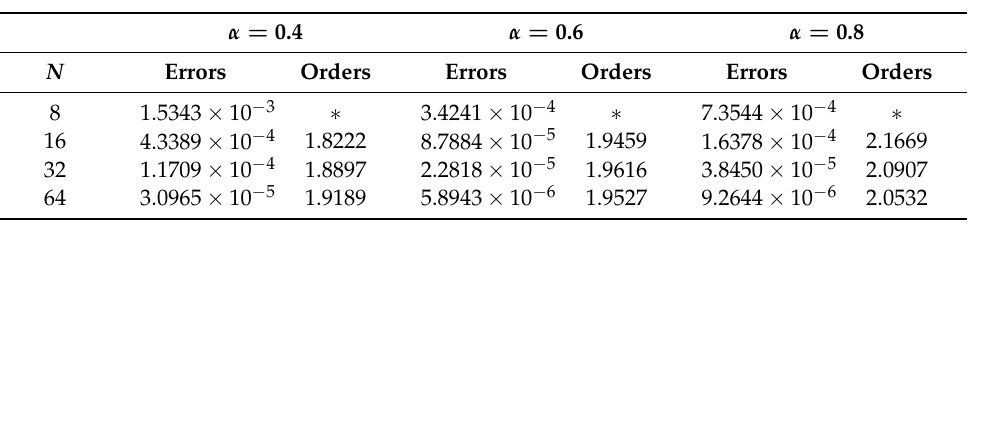
Table 7. Errors and orders in temporal direction for Scheme III (Example